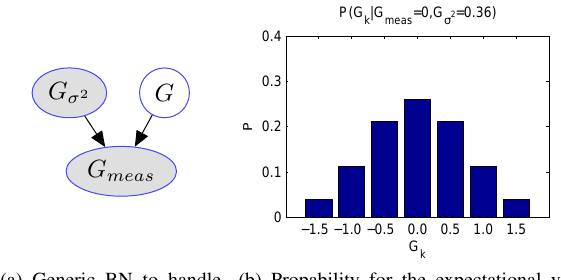
Figure 9: Handling noisy